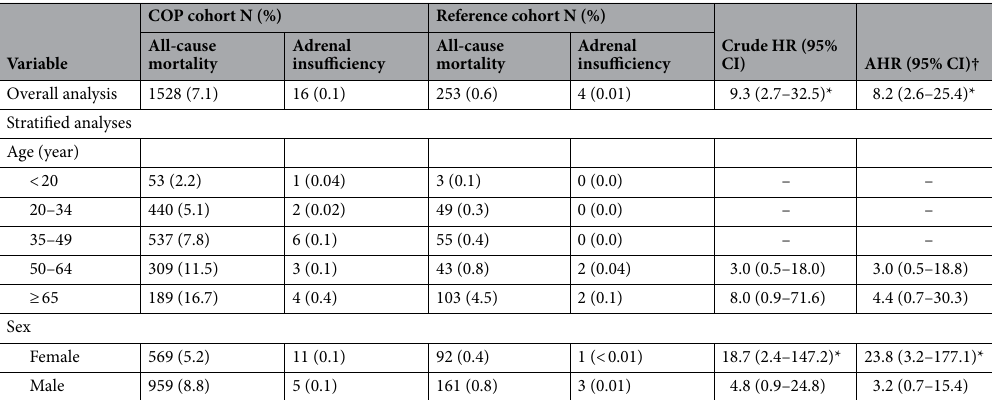
Table 3. Comparison of the risk for adrenal insufficiency at follow-up within 1 year between the COP and reference cohorts using competing risk survival analyses. COP, carbon monoxide poisoning; HR, hazard ratio; AHR, adjusted hazard ratio; CI, confidence interval. * p < 0.05. †Adjusted for sex, underlying comorbidities including liver disease, thyroid disease, and mental